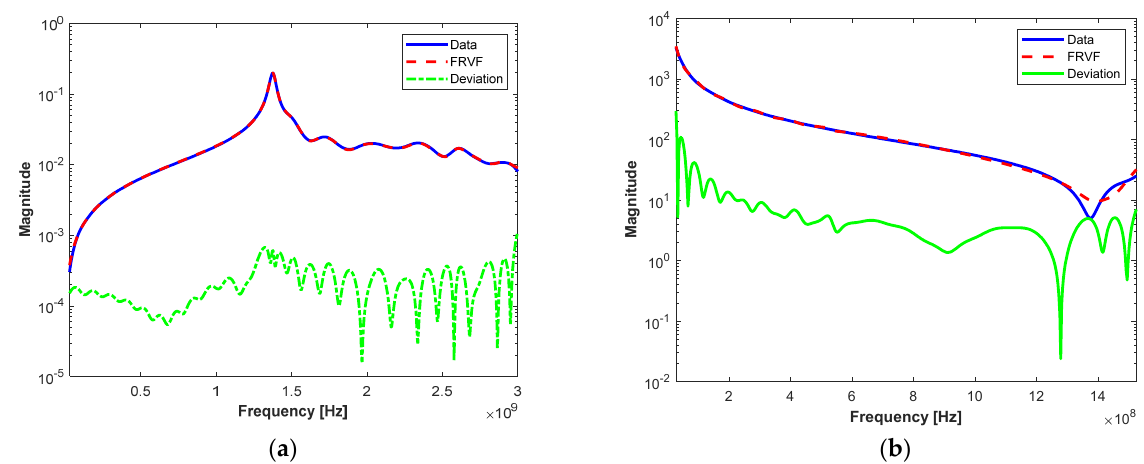
Figure 10. Fitting result of impedance and admittance of antenna with VF method: ( a ) admittance; ( b ) impedance.